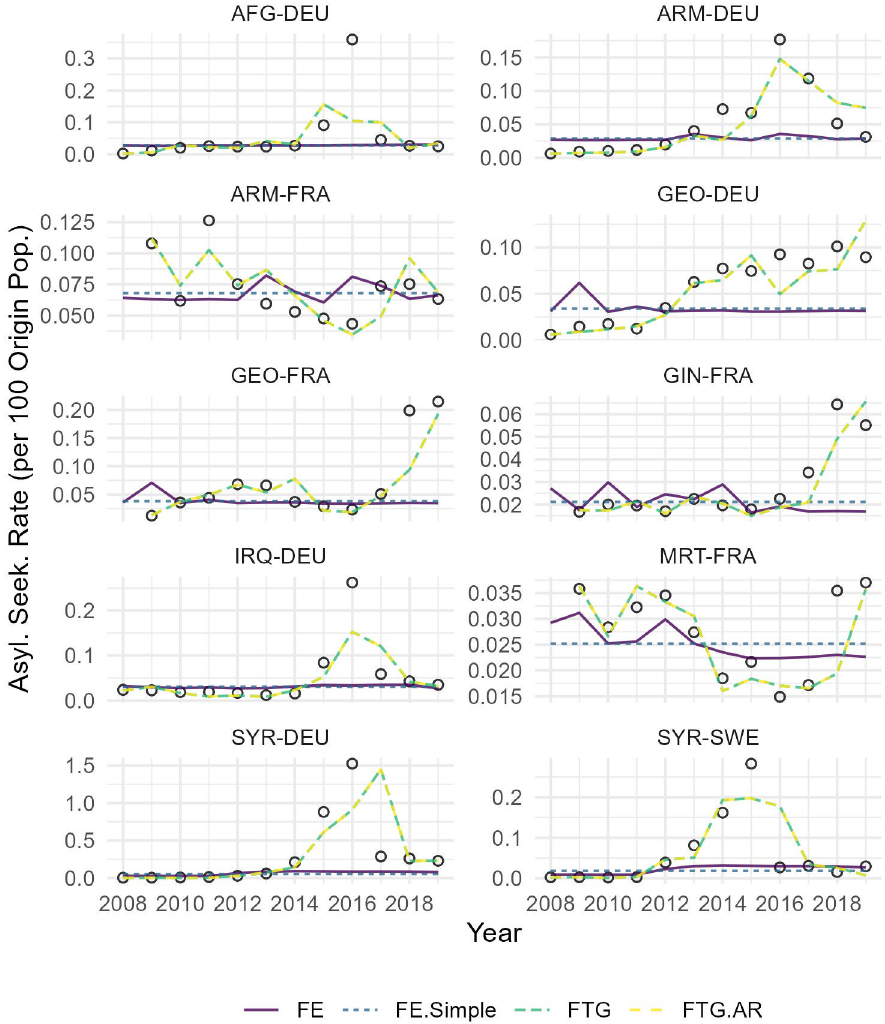
Fig 8. Observed and predicted temporal trends of forced migration. The observed data are represented by dots. The selected flows represent the top 10 asylum-related migration flows to Europe during 2008-2019. The temporal trends are predicted by the model trained on the data 2008-2018 (i.e., the longest data split in Fig